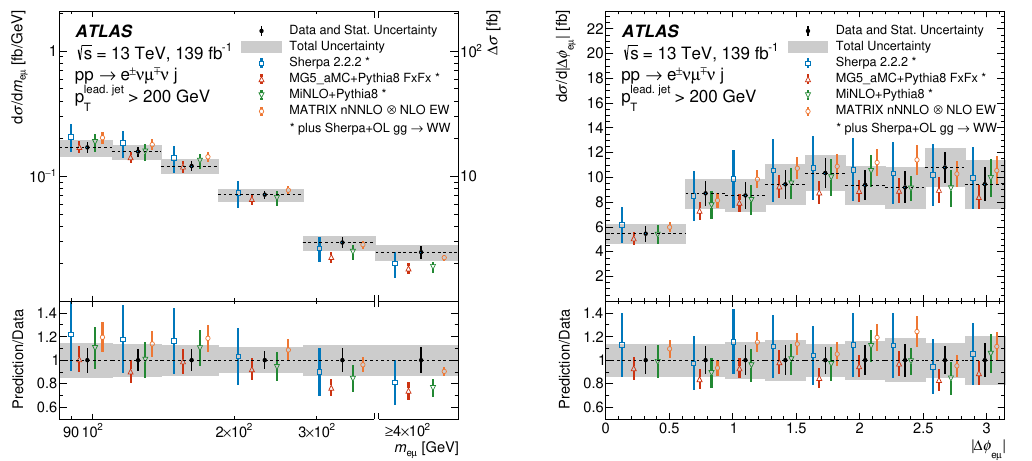
Figure 9 . Measured fiducial cross-sections of WW +jets production for m eµ (left) and ∆ φ ( e, µ ) (right) in the fiducial phase space requiring p lead. jet > 200 GeV. The last bin of the m eµ distribu- T tion is inclusive and the corresponding integrated cross-section is indicated by the right-hand-side axis. The measured cross-section values are shown as points with error bars giving the statistical uncertainty and solid bands indicating the size of the total uncertainty. The results are compared with the NNLO prediction with extra NLO EW corrections and NLO corrections for gg → WW production (denoted MATRIX ⊗ NLO EW) as well as NLO+PS predictions from Sherpa 2.2.2, MadGraph5 _a MC@NLO + Pythia 8 with FxFx merging, and Powheg MiNLO + Pythia 8 for q ¯ q initial states, combined with Sherpa + OpenLoops (LO+PS) for the gg initial state. The Sherpa 2.2.2 + OpenLoops prediction is normalized to the total cross-section calculated at NLO in QCD. Theoretical predictions are indicated as markers with vertical lines denoting PDF and scale